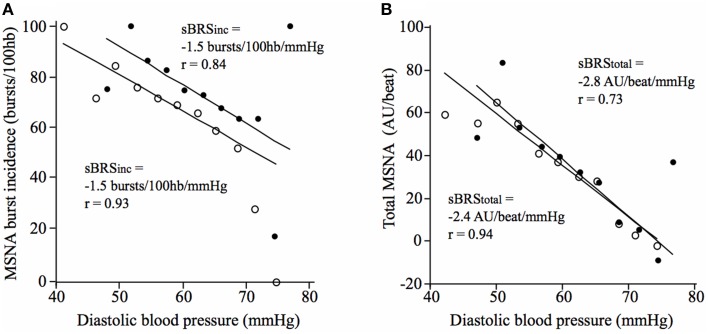
Vascular sympathetic baroreflex slopes for a 21-year old male in the morning (closed circles) and afternoon (open circles) using (A) the vascular sympathetic BRSinc method, and (B) the vascular sympathetic BRStotal method.